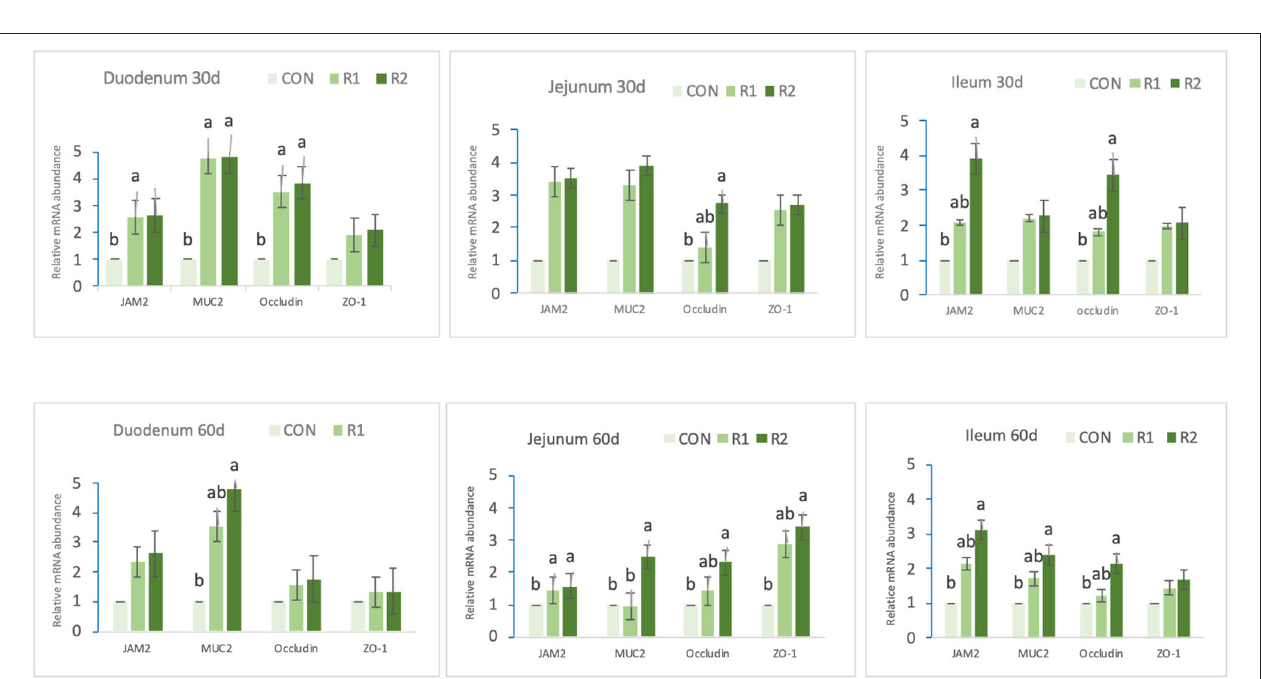
FIGURE 1 | Effects of dietary catalase supplementation on intestinal microbial composition of 30-day-old yellow broilers. Data are the mean ± SEM ( n = 8). CON-broilers fed the basal diet,R1-broilers fed the basal diet supplemented with 150U/kg CAT, R2-broilers fed the basal diet supplemented with 200U/kg CAT a,b,c within the same intestinal segment and the same strain, means with different superscript letters differ ( P < 0.05).